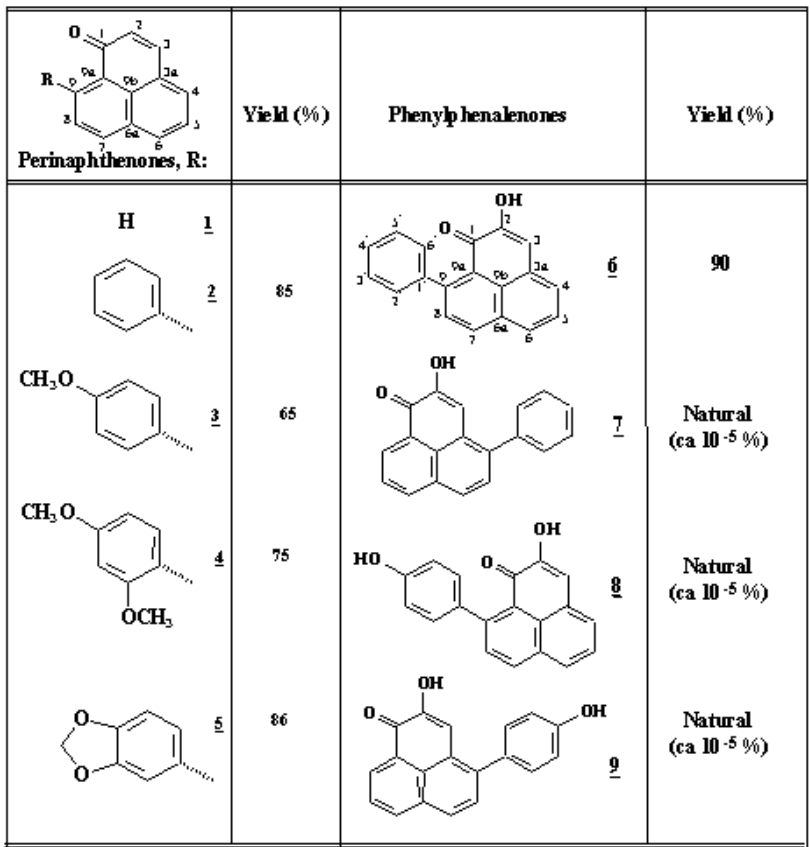
Table 1. Structure and yield of phytoalexins and structural